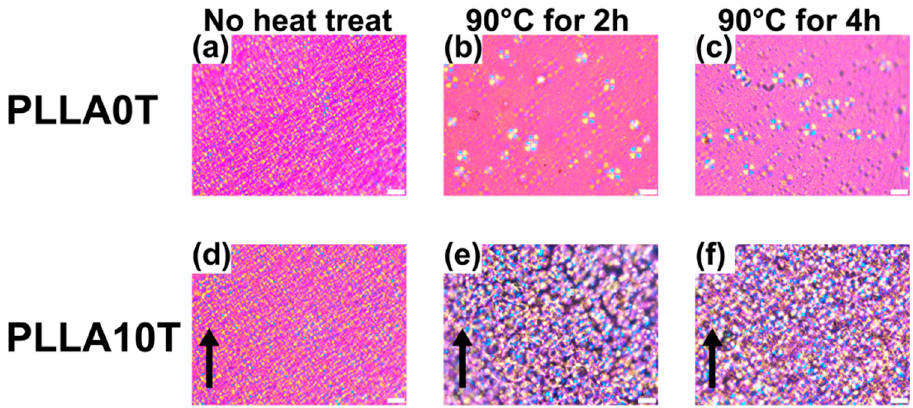
Figure 8. Polarization microscope images of PLLA films: ( a ) PLLA0T, ( b ) PLLA0T2, ( c ) PLLA0T4, ( d ) PLLA10T, ( e ) PLLA10T2, and ( f ) PLLA10T4. The black arrow indicates the direction of the magnetic field. White bar = 50 μ m.